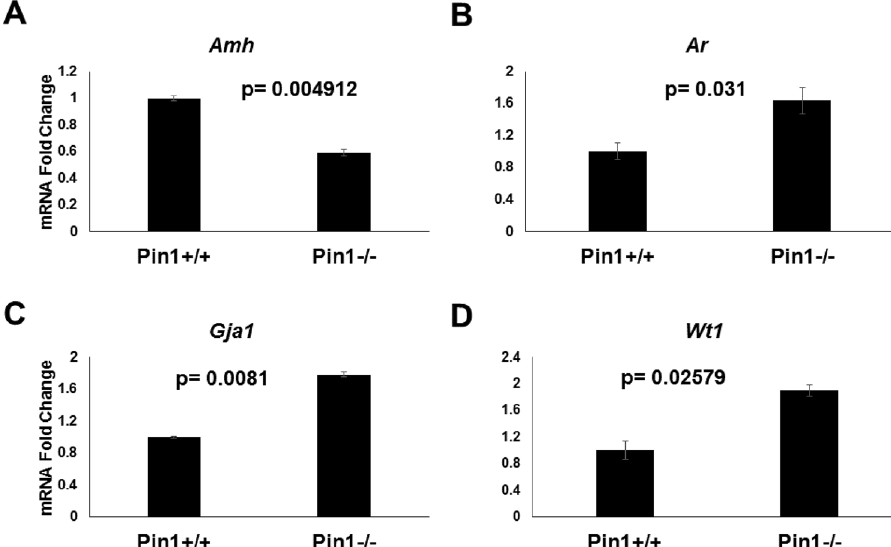
Figure 7. Sertoli cell markers are dysregulated in Pin1 − / − testes. ( A ) Amh (antimüllerian hormone) mRNA transcript expression was analyzed in Pin1 + / + and Pin1 − / − testes. ( B ) Ar (androgen receptor) and ( C ) Gja1/ connexin 43 mRNA levels were also analyzed in the same tissue. ( D ) The expression profile of the Sertoli cell- specific marker Wt1 (Wilms tumor) was analyzed by qRT-PCR. RNA from whole snap-frozen testicular tissue was extracted by Trizol digestion after homogenization using a mortar. qRT-PCR was performed using Sybr green reagent in an Applied Biosystems 2500